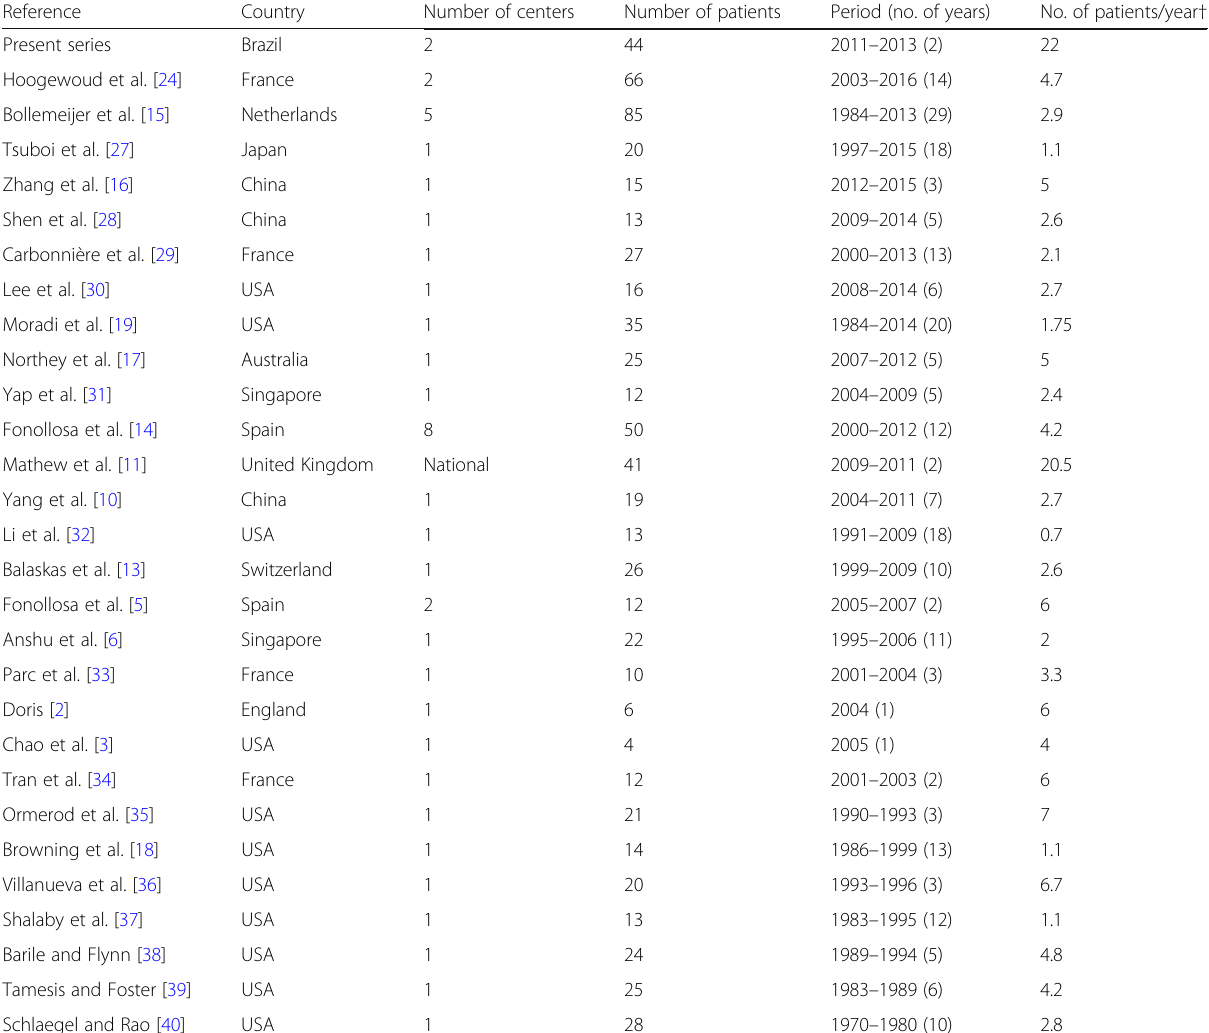
Table 3 Comparison of published series on syphilitic uveitis